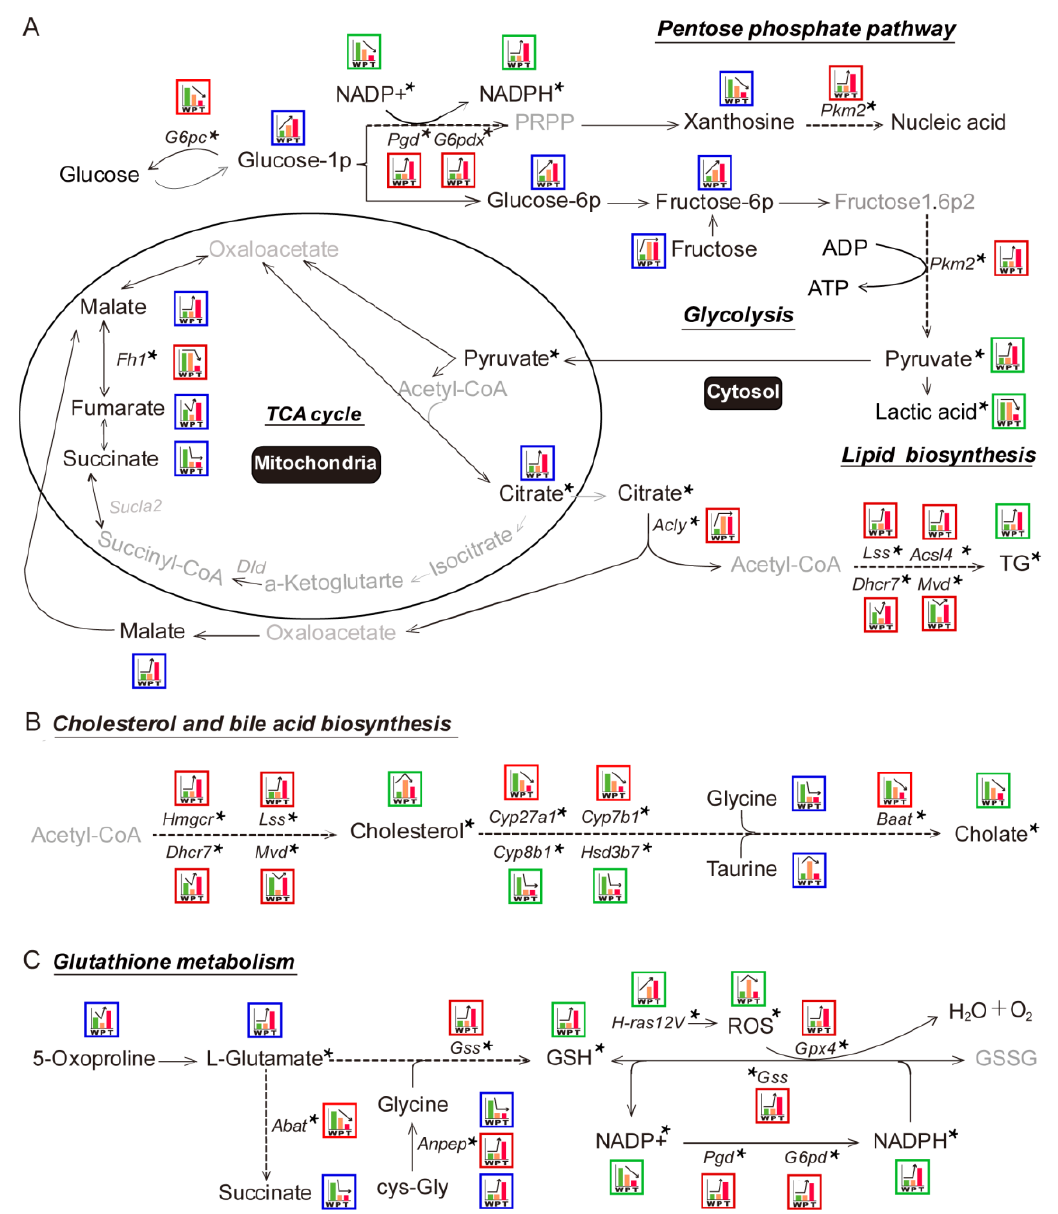
Figure 2. Schematic representation of the metabolic pathways in hepatocarcinogenesis. An exhaustive analysis of the integrated metabolomic and transcriptomic data identified multiple relevant metabolic pathways for further validation and investigation. ( A ) Metabolic pathways associated with glycolysis, tricarboxylic acid (TCA) cycle, pentose phosphate pathway (PPP), and lipid biosynthesis. ( B ) Metabolic pathways associated with cholesterol and bile acid synthesis. ( C ) Metabolic pathways associated with glutathione. The blue- and red-bordered boxes depict the expression-patterns of metabolomics and transcriptomics data, respectively. The green bordered boxes indicate the expression-patterns of metabolites that were detected directly. The relative expression levels of W (green histogram bar), P (orange histogram bar), and T (red histogram bar) are demonstrated in boxes; the different height of histogram bars indicate expression levels. The asterisk in the upper right corner of DEGs or DEMs indicates that these metabolites or enzymes were validated (detailed information is given in Figures 3 and 4). Grey word represents the undetected metabolites in the present study. TG: triglyceride; NADPH: nicotinamide adenine dinucleotide phosphate; GSH: glutathione; ROS: reactive oxygen species. Other abbreviations are the same, as mentioned in Figure 1.